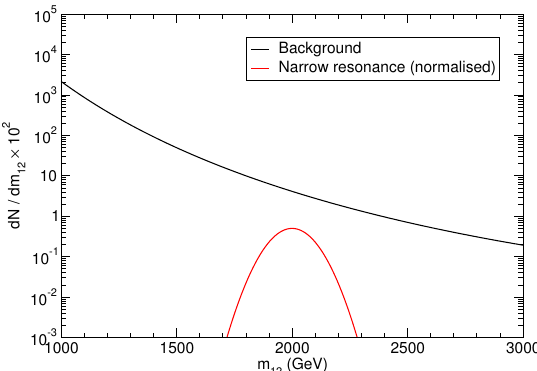
Figure 7 . Background distribution used as benchmark for our analysis, and p.d.f. distribution (normalised) of a 2 TeV narrow